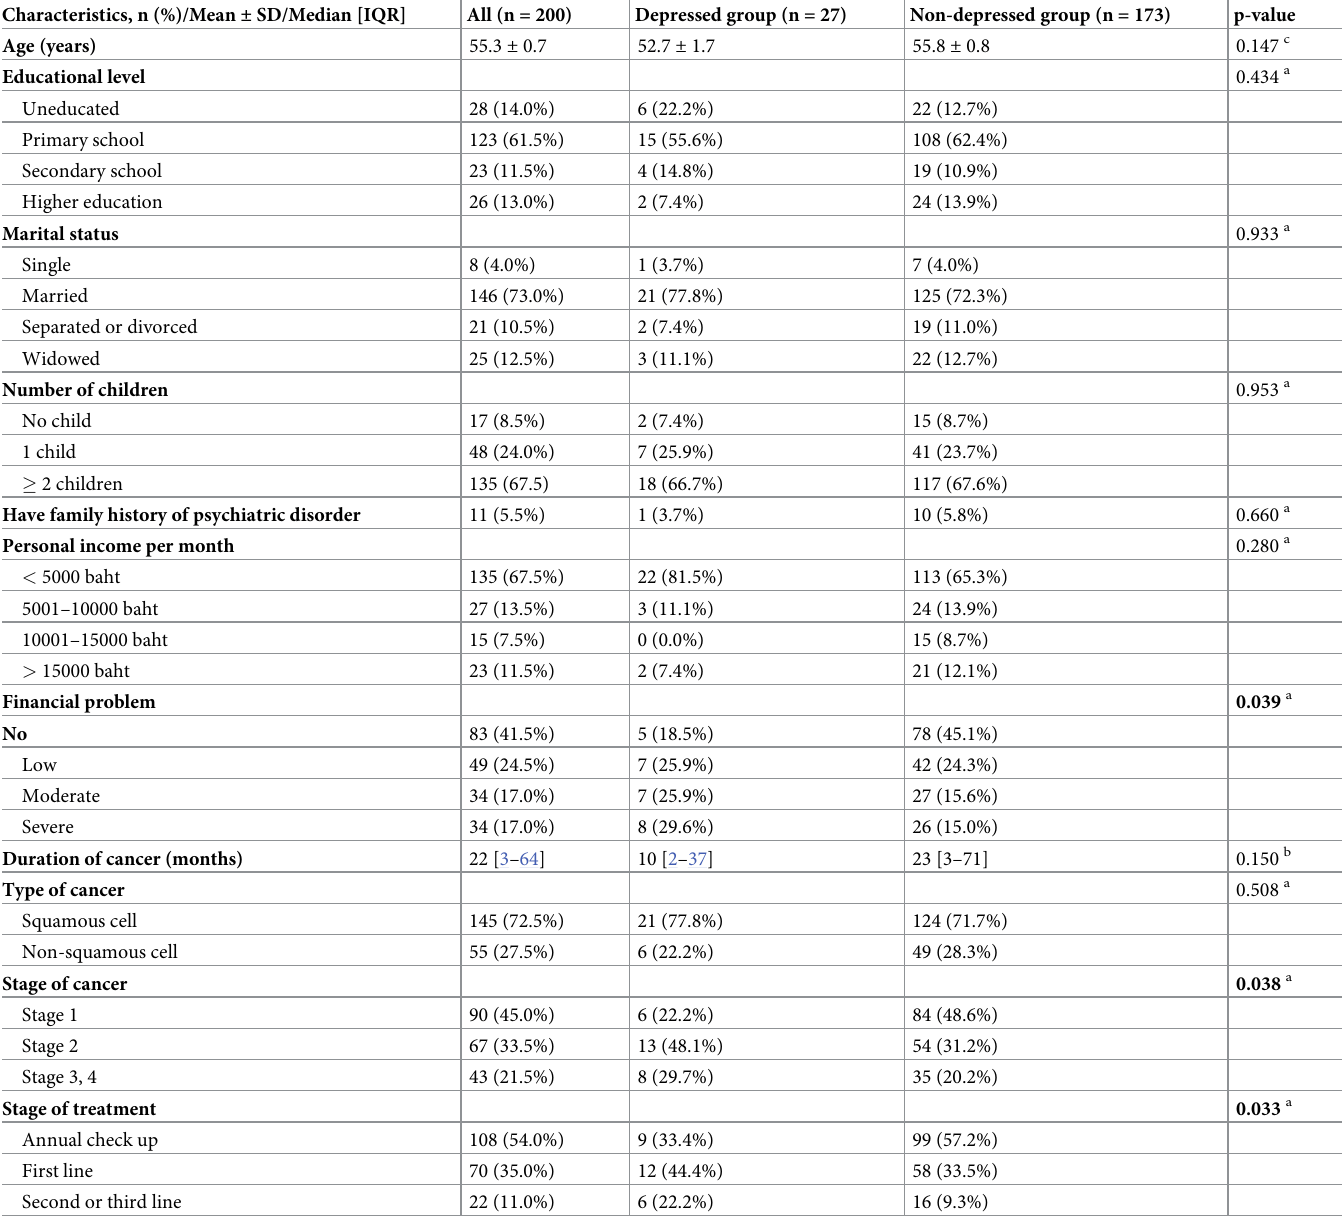
Table 1. Characteristics of the study